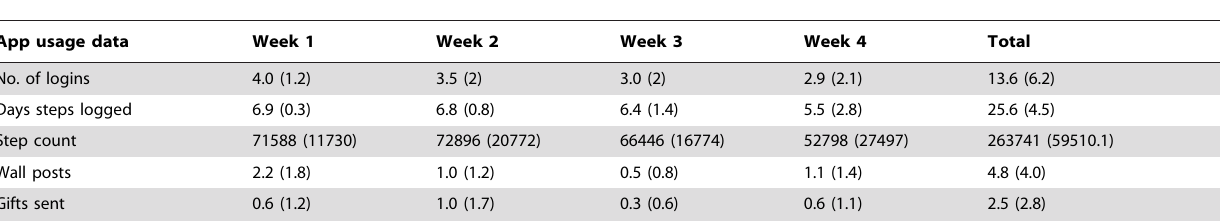
Table 3. Shows usage data recorded by the Mums Step It Up